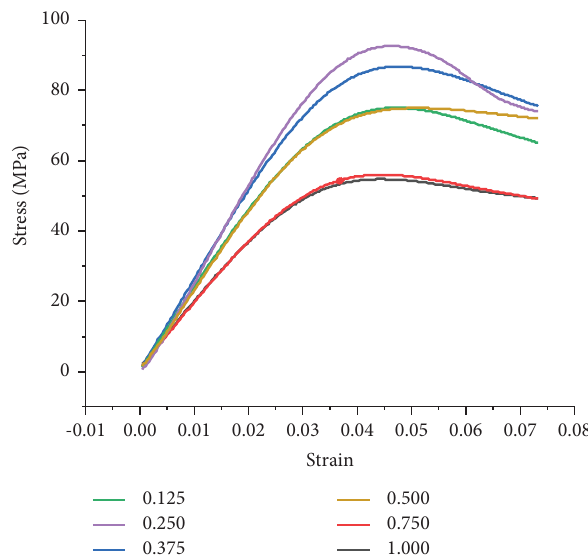
Figure 16: Stress-strain curve of stones with a k CE values. or vacuum mixing conditions and that of